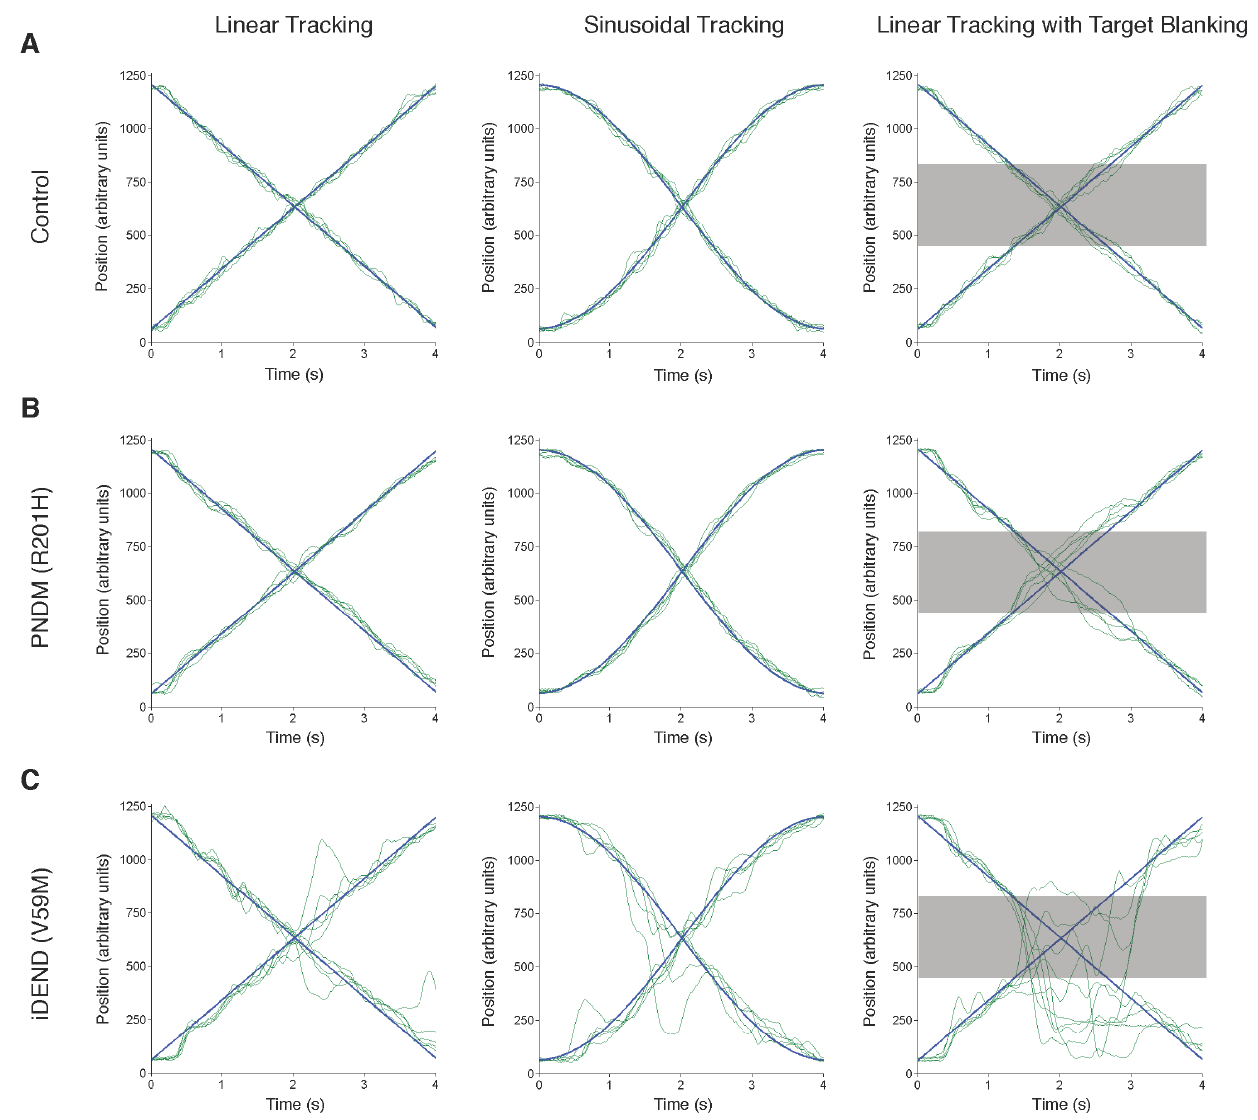
Figure 1. Representative traces from tracking tasks completed by a control participant, and patients with PNDM and iDEND. Panels show the superimposition of 5 rightward (positive slope) and 5 leftward (negative slope) tracks from a control subject (A), a PNDM patient (R201 H mutation) (B), and an iDEND patient (V59 M mutation) (C). The person who provided the traces shown in (A) was the matched control of the iDEND patient whose traces are shown in (C). Participants tracked targets that moved at constant velocity (first column), variable velocity – accelerating and decelerating smoothly (second column), and constant velocity but with the visual presentation of the target blanked during the period indicated by the grey bar (third column). Blue lines indicate the movement of the target. Green lines indicate the movement of the cursor, which was controlled by the participant.